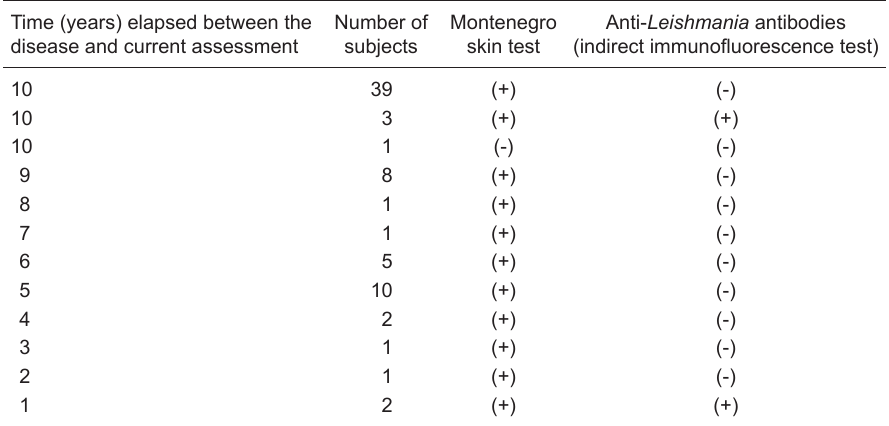
Table 1. Response to the Montenegro skin test and indirect immunofluorescence test serology of subjects up to 10 years after cure of visceral leishmaniasis (Vila São José, MA, Brazil). Time (years) elapsed between the Number of disease and current assessment